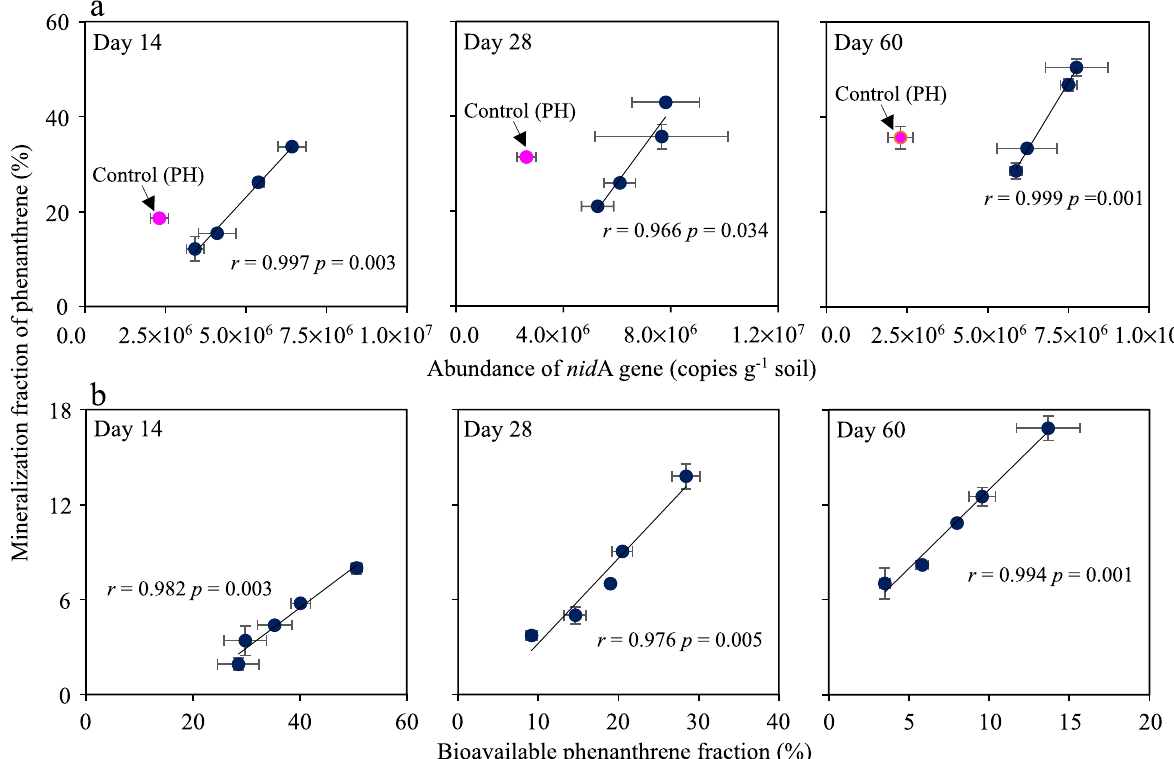
Fig. 3 Correlations between the mineralization fraction of phenanthrene and the nid A gene abundance in PHS ( a ) or its bioavailable fraction in PLS ( b ) on different incubation